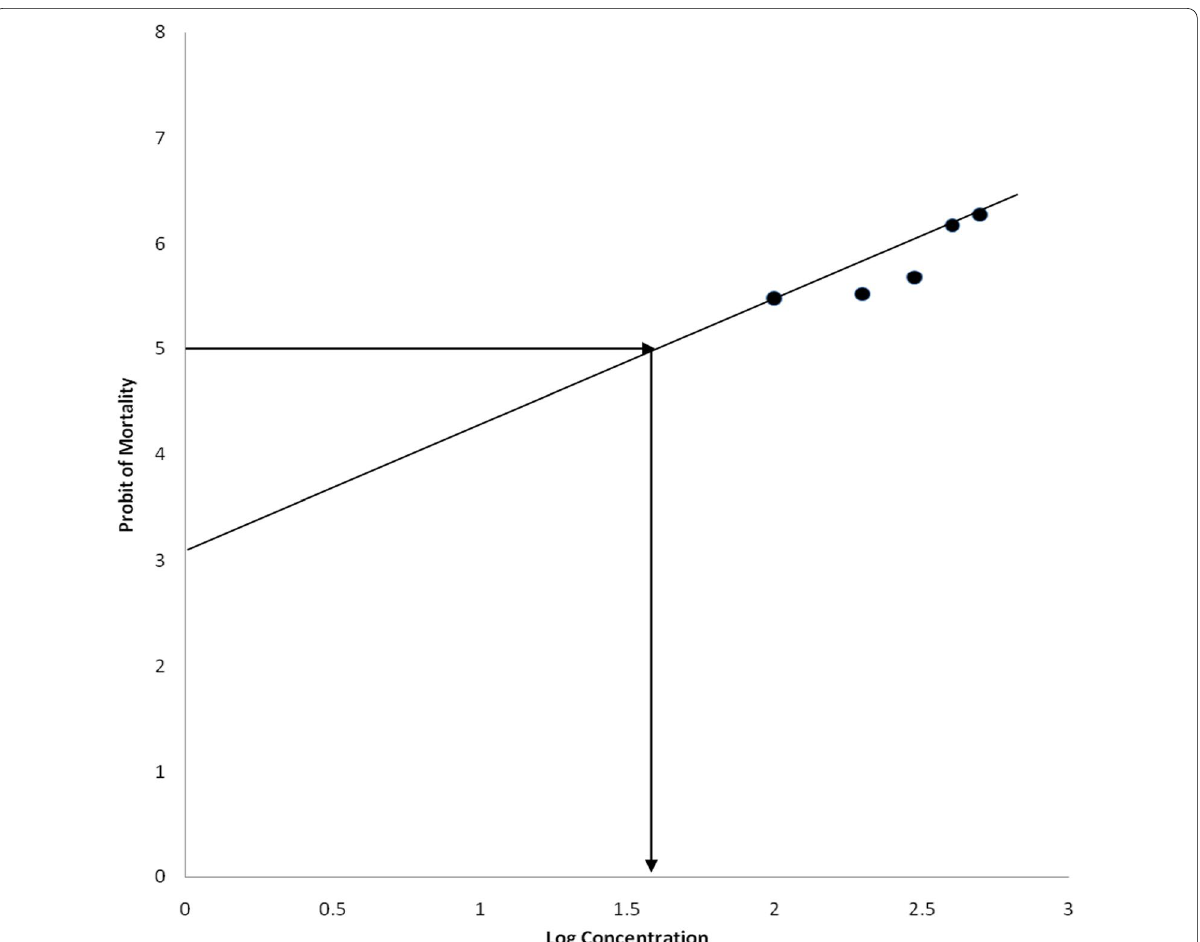
Fig. 4 Graph of Probit of Mortality of Anopheles larvae /Log of Concentration of Ethanolic Leaf Extract of Cymbopogon citratus showing the LC 50 at Lethal Toxicity